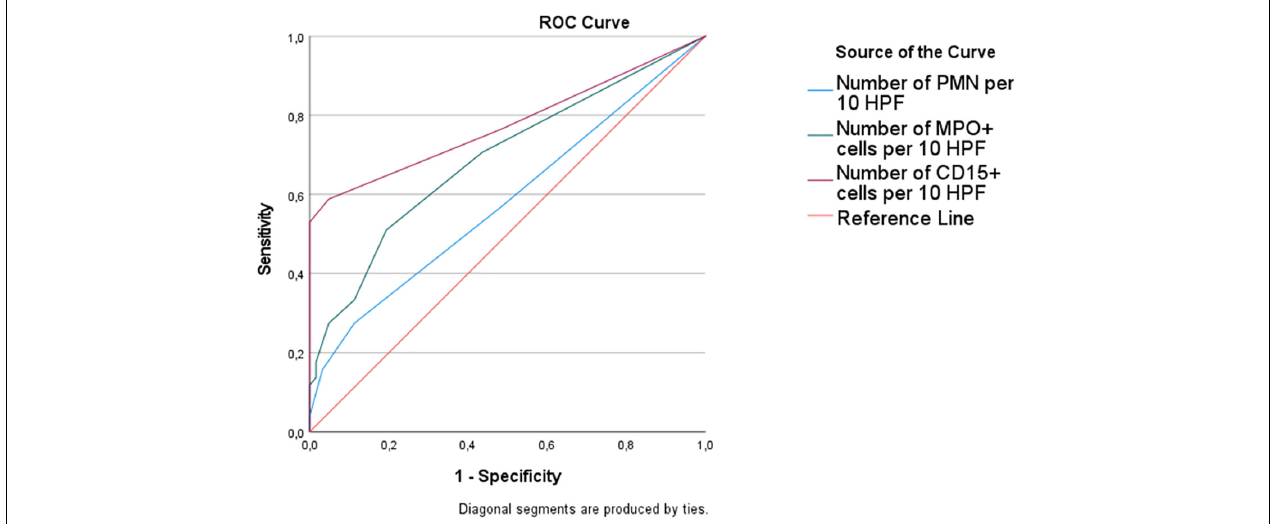
FIGURE 2 | Receiver operating characteristic (ROC) curve for the diagnosis of wound vitality. The area under curve was higher for CD15 (0.78) than MPO (0.69), followed by standard histological count